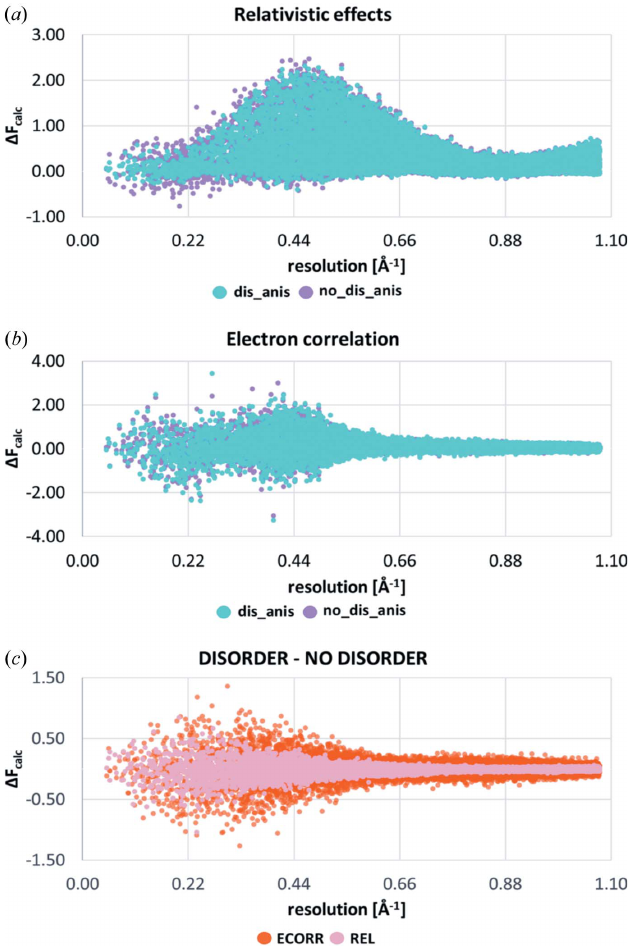
Figure 8 Differences in dynamic structure factors showing the effects of the treatment of hydrogen ADPs on the distribution of differences in the calculated dynamic structure factor amplitudes due to the relativistic effects and electron correlation. On the x axis, sin (cid:4) / (cid:2) (A˚ (cid:5) 1 ) is plotted up to the maximum experimental resolution. On the y axis, the difference in dynamic calculated structure factors is plotted in absolute scale ( (cid:2) F calc